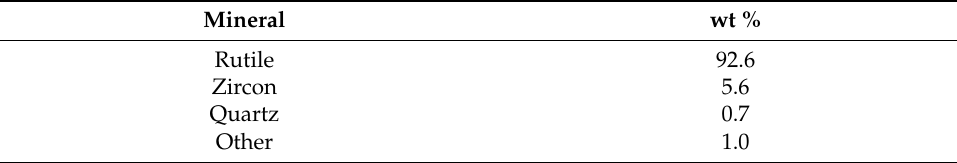
Table 4. Mineralogical composition of rutile concentrate from MS